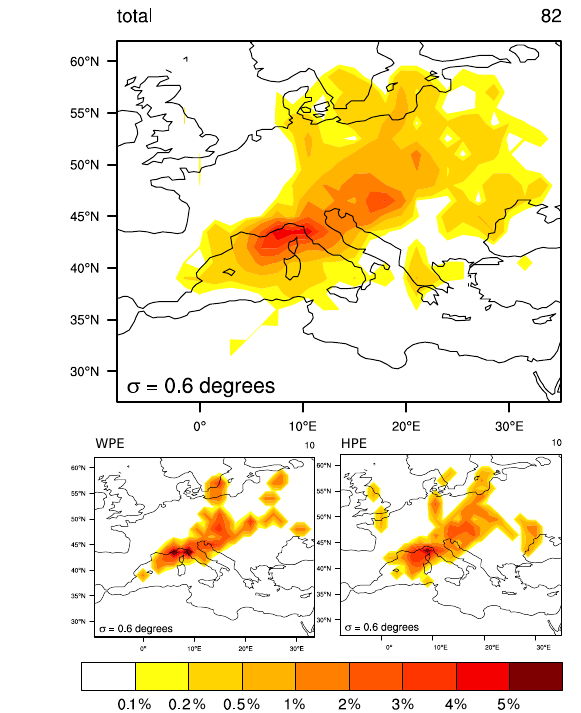
Figure 3. Probability density field of all detected Vb cyclone cen- tres (top panel), of the heavy precipitation events (HPEs) (bottom left panel) and of the weak precipitation events (WPEs) (bottom right panel). The shading shows how probable it is that a Vb cy- clone centre is located at the according grid point at any time step in the 1979–2013 period.